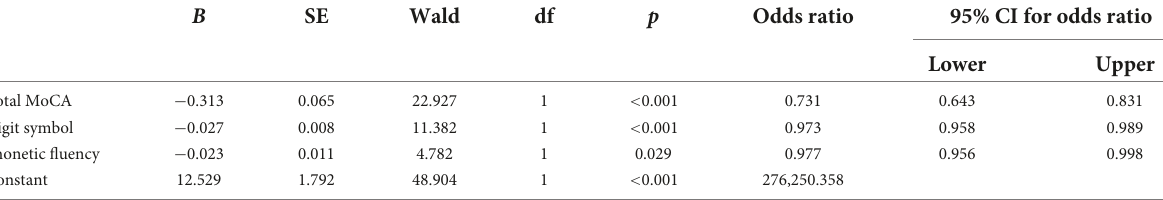
TABLE 4 Logistic regression classifying participants in PCC and HC groups based on significant neuropsychological results.